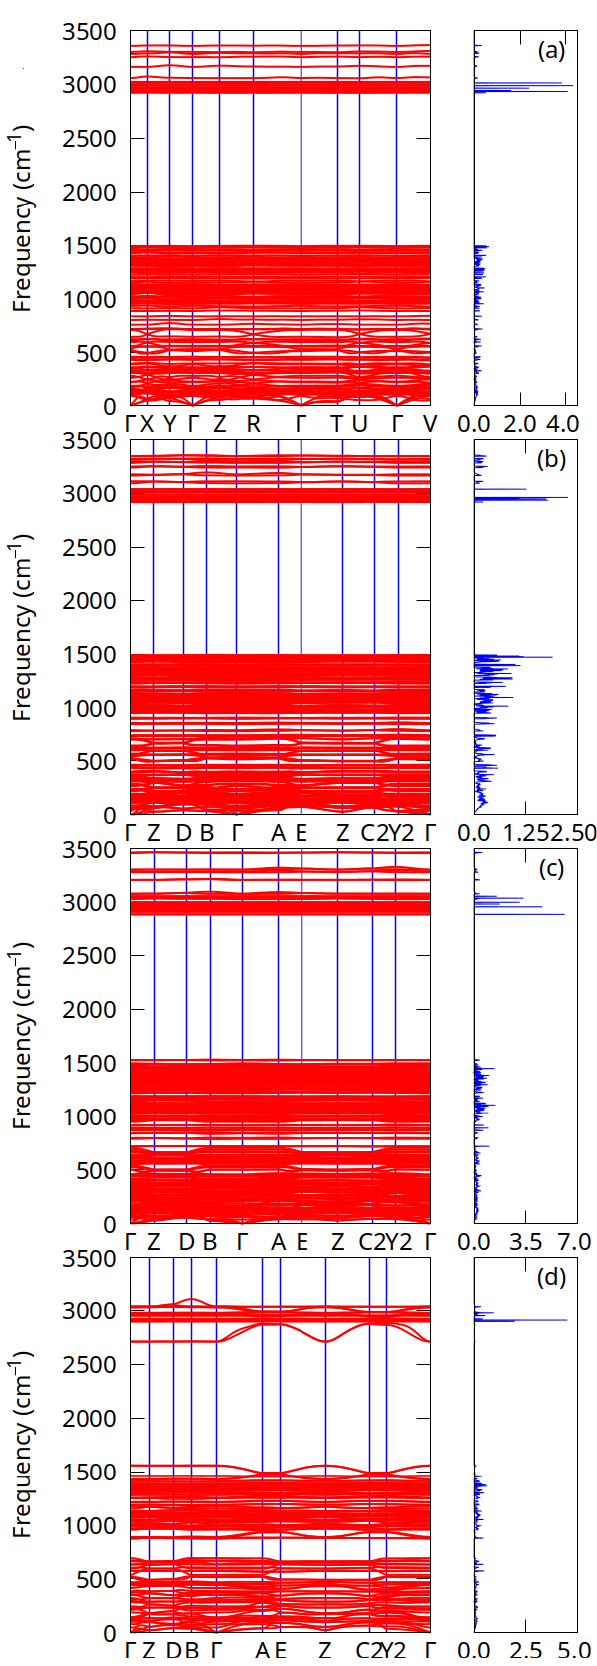
Figure 3. Harmonic phonon dispersion relations along high symmetry points ( left ) and phonon density of states ( right ): ( a ) cellulose I α , ( b ) cellulose I β , ( c ) cellulose II, and ( d ) cellulose III 1